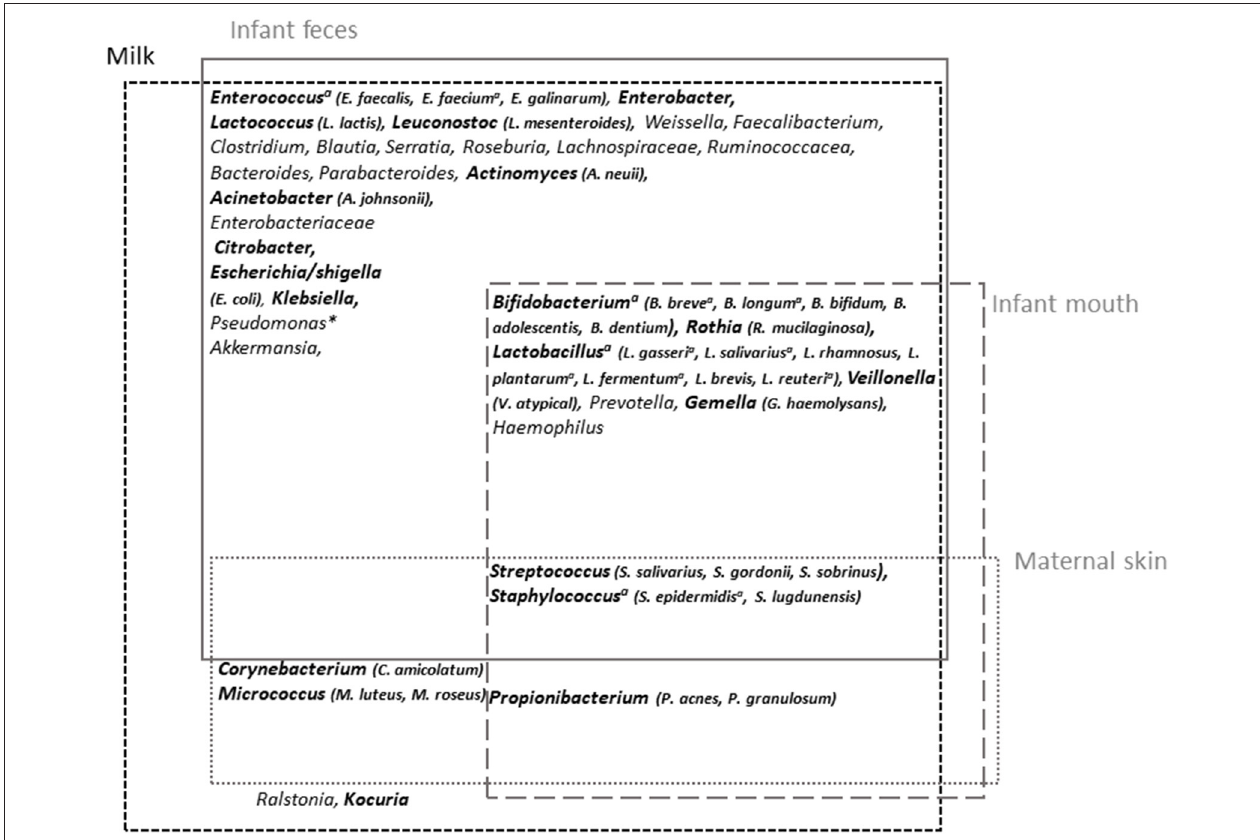
FIGURE 3 | Milk microbiota major taxa and overlap with infant feces and mouth and maternal skin microbiota. Overview of milk microbiota major taxa and their possible origin [based on the reviews by Oikonomou et al. ( 89) and Jost et al. (90) for milk microbiota and Byrd et al. (119) and Xiao et al. (120) for maternal skin and infant oral microbiota, respectively, and based on comparative studies between microbiota associated with these different sites (98–100, 106, 121)]. The taxa in bold correspond to those for which isolates have been obtained ( ∼ viable fraction of milk microbiota). a Taxa for which shared strains between milk and infant feces have been reported; *generally considered as a